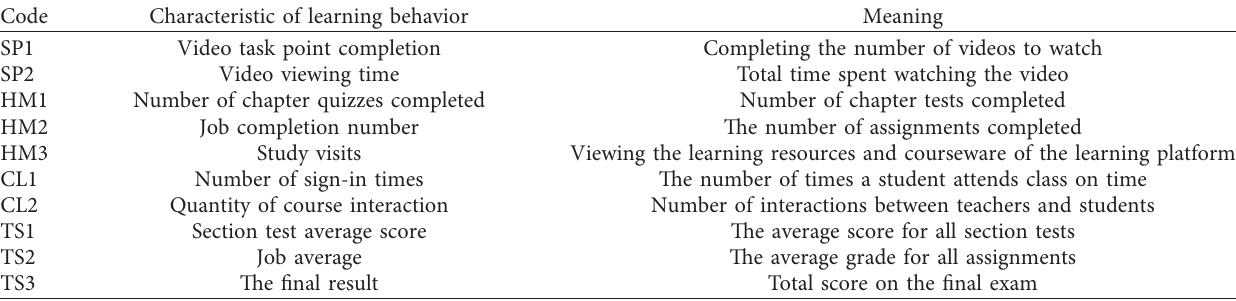
Table 1: The meanings and codes of students’ learning behavior characteristics and achievements.